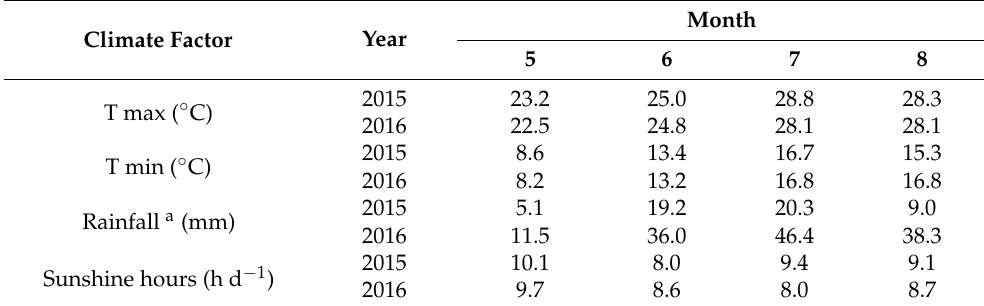
Table 1. Weather data for Wuchuan county, Inner Mongolia, China, in 2015 and 2016. Climate Factor